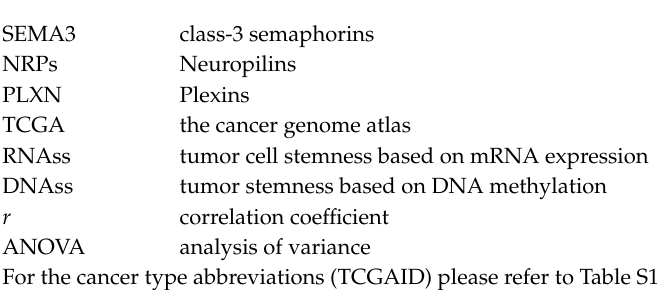
Table S1: summary of TCGA pan-cancer data, Table S2: correlation between mRNA and protein level expression of SEMA3s and their receptors, Table S3: correlation between SEMA3 receptors NRPs and PLXNs and SEMA3 key signal transducers, Table S4: correlation between SEMA3 receptors and immune checkpoint molecules, Table S5: the list of significantly correlated genes and drugs with | r | > 0.4 and p -values < 0.005, Table S6: correlation between SEMA3 receptors and tumor stemness scores, tumor infiltration scores, and tumor purity for breast cancer, Figure S1: boxplots to show the expression levels of NRPs and PLXNs in cancerous and adjacent normal tissues for all 33 cancer types, Figure S2: association of the expression of NRPs and PLXNs with patient progression free interval (PFI) for di ff erent cancer types, Figure S3: correlation matrix plots to show the association of the expression of NRPs and PLXNs with the immune score and estimate scores of 25 di ff erent cancer types based on ESTIMATE algorithm, Figure S4: expression of NRPs and PLXNs in NCI-60 cell lines, Figure S5: scatter plots to show the correlation of the expression of NRPs and PLXNs with the level of immune checkpoint molecules PD1 / PDL1 and CTLA-4 in breast cancer tumours, Figure S6: boxplots to show the gene expression of NRPs and PLXNs in di ff erent molecular subtypes of BLCA, OV, KIRC, and HNSC tested with ANOVA ( p <